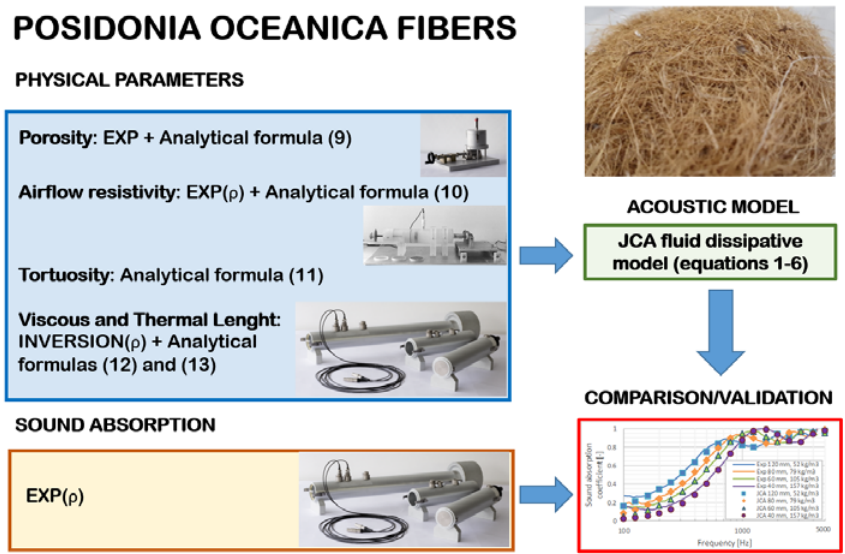
Figure 3. Schematic diagram of the procedure for the characterization of Posidonia fibers and acoustic modelling.